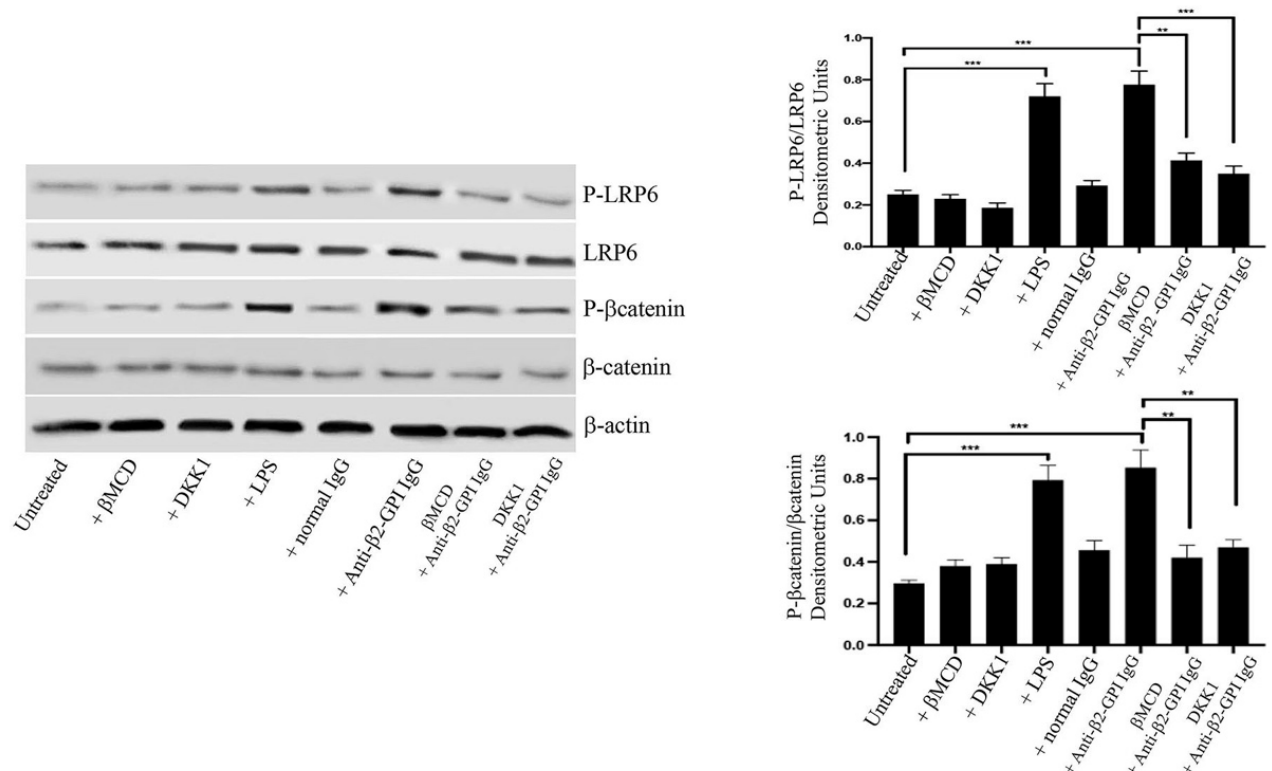
Figure 1. LRP6 and β -catenin phosphorylation following triggering with anti- β 2-GPI antibodies. HUVECs, untreated or treated with affinity-purified anti- β 2-GPI antibodies for 45 min, or with normal human serum IgG or LPS, in the presence or in the absence of DKK1 or M β CD, were analyzed by western blot using anti-phospho-LRP6 mAb, anti-LRP6 mAb, anti-phospho- β -catenin mAb or anti- β -catenin mAb. As a loading control, β -actin was employed. Densitometric analysis is shown. Results represent the mean ± SD from three independent experiments. ** p < 0.005, *** p < 0.001.